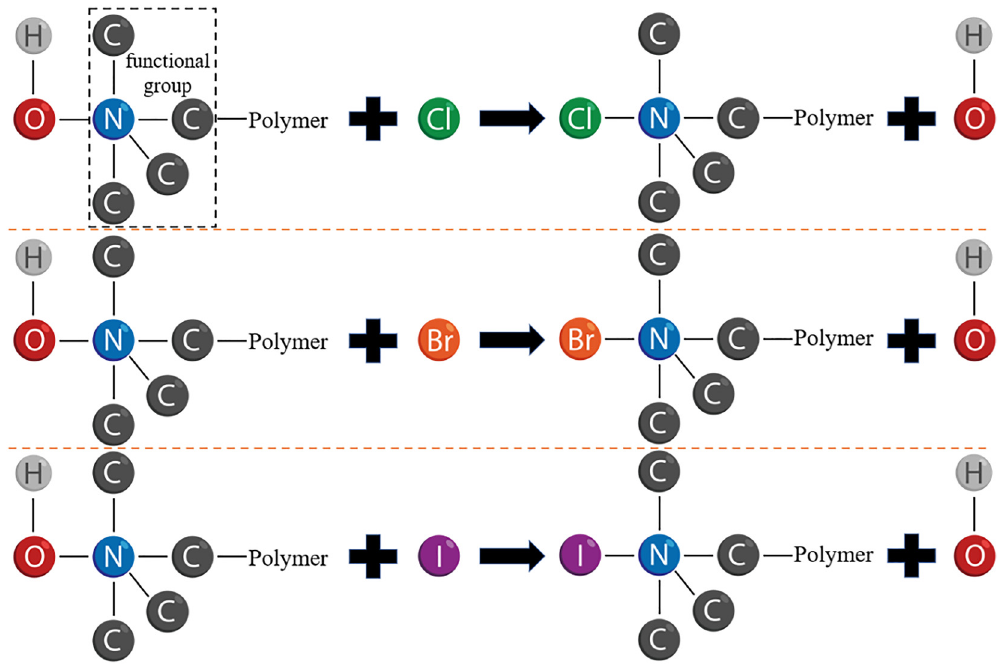
Figure 1: Schematic of type conversion reaction principle for anion exchange